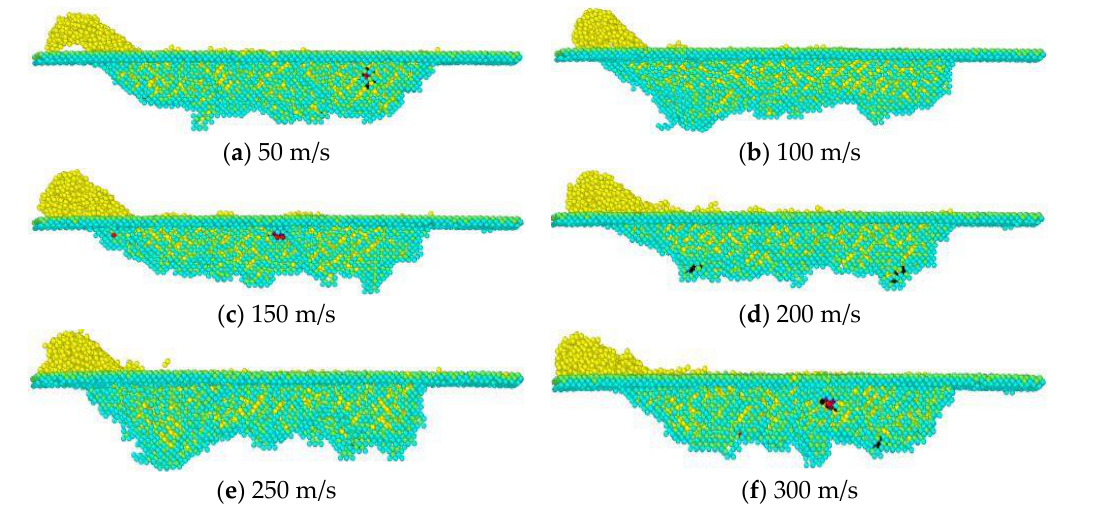
Figure 12. Scratch damage morphology with different scratch speeds.